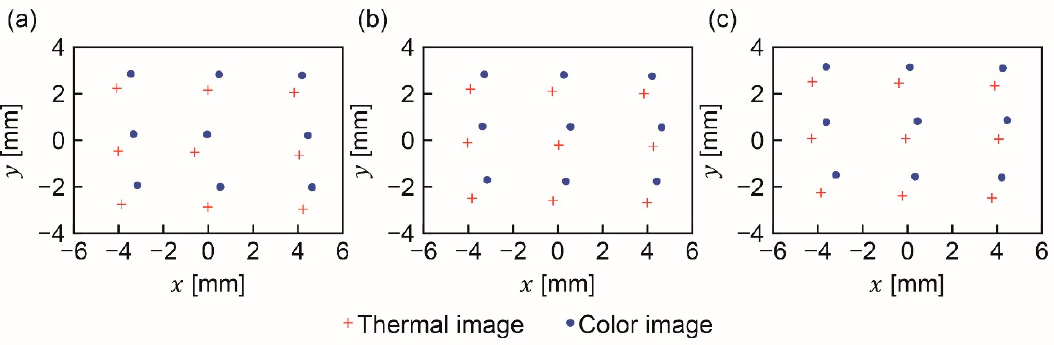
Figure 8. Positions of captured light sources at distances of ( a ) 0.5, ( b ) 1, and ( c ) 2 m on thermal and color images.